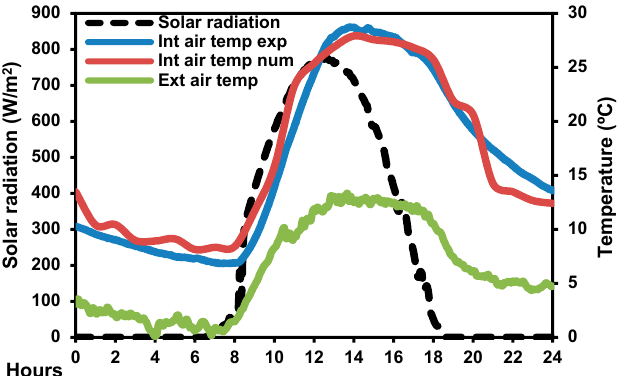
Figure 7. Experimental and numerical simulation data for the 15th of March. Experimental interior air temperature (together with exterior air temperature and solar radiation) and numerical interior air temperature.